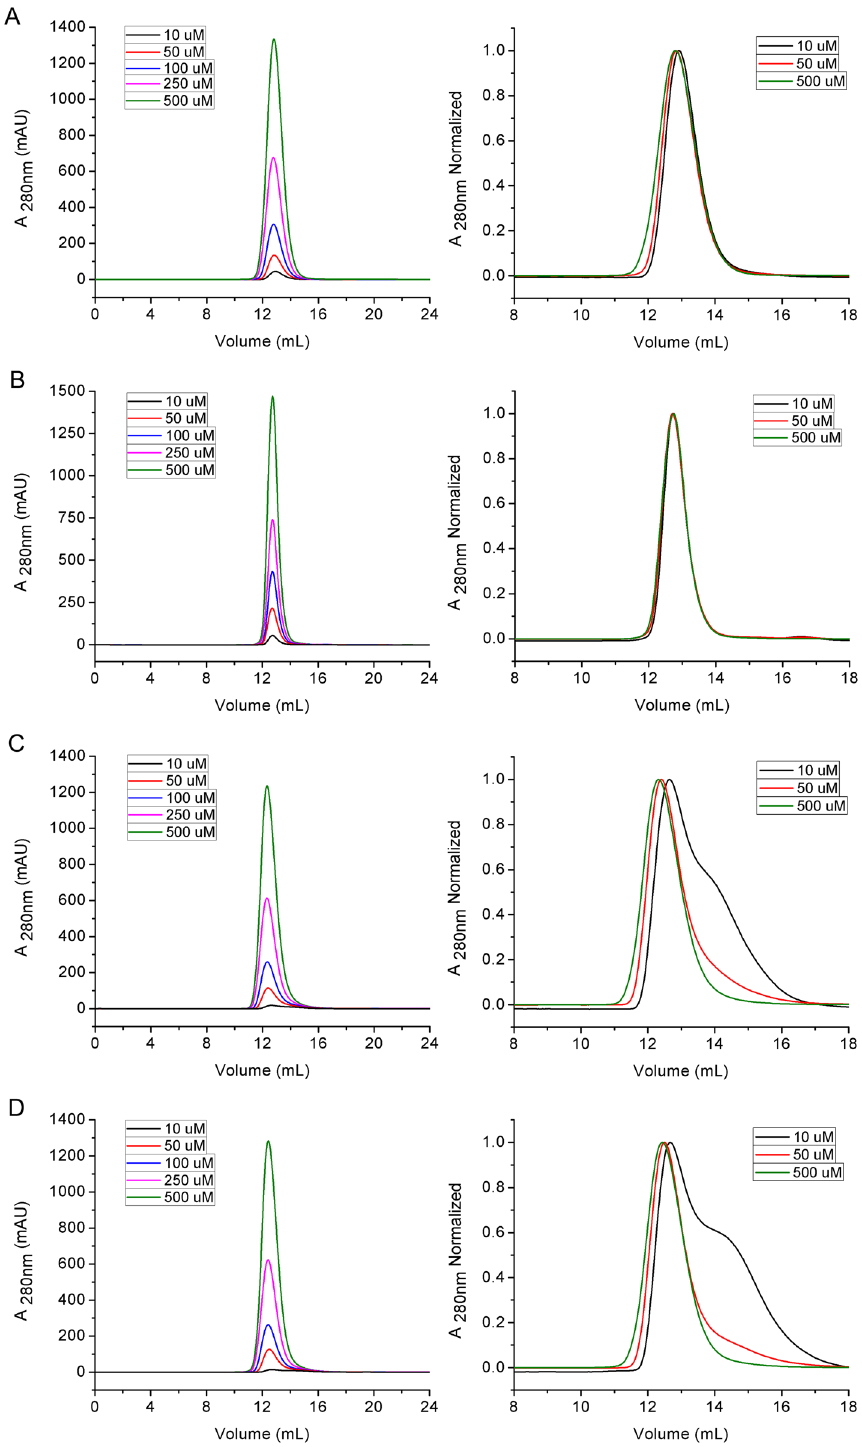
Figure 4. Identification of the dimer interfaces of TDP(1–77) by mutagenesis and SEC. ( A ) SEC profiles for TDP(1–77)-GB1-C39/C50S. ( B ) L27/I60/V57A mutant. ( C ) L71/Y73A mutant. ( D ) V72/V74/Y43A mutant. The right panels show the normalized chromatograms. The mutants were generated based on TDP(1–77)- GB1-C39/C50S. The proteins were diluted to the indicated concentrations with Buffer A and loaded onto a Superdex-75 10/30 GL